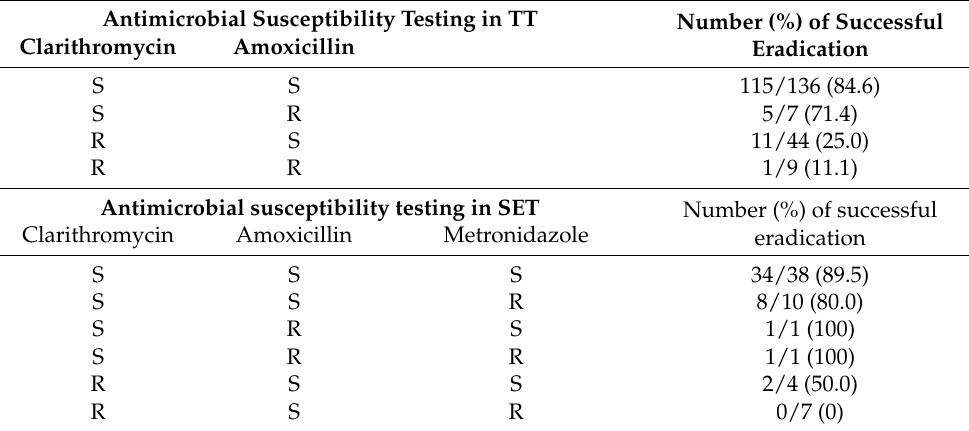
Table 3. Antimicrobial susceptibility testing results.